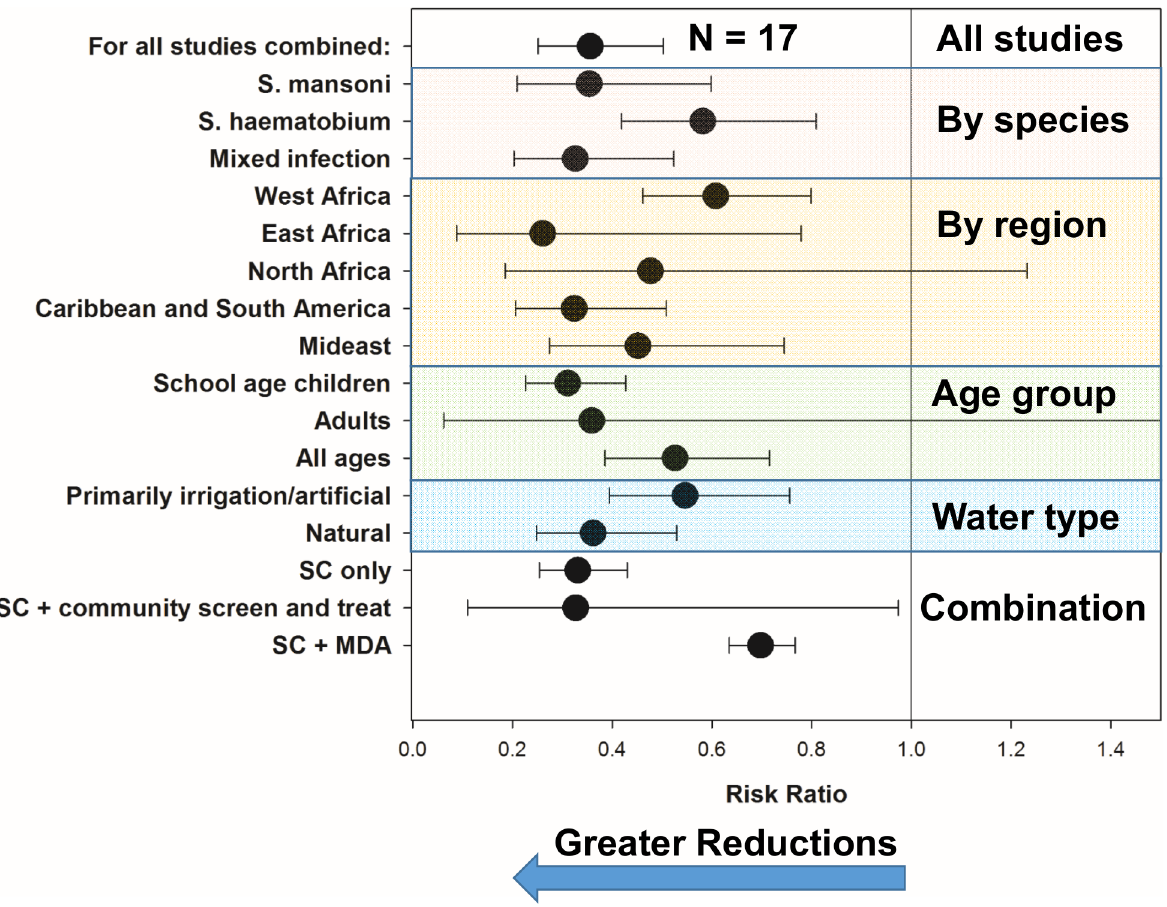
Fig 6. Risk ratios for interval Schistosoma infection incidence after implementation of mollusciciding programs. Black circles indicate risk ratios (RR) estimated by random effects meta-analysis for Schistosoma infection incidence after mollusciciding, as compared to pretreatment levels. Whisker bars indicate the 95% confidence interval for the RR estimates. Numeric details are provided in Supporting Information file S3 Table. Results are shown for all studies reporting human incidence data after implementation of control (top line, N = 17), and for study subgroup categories classified according to parasite species, geographic region, which age groups were included, the types of water bodies treated, and whether the program included snail control (SC) only, or mollusciciding combined with some form of drug treatment intervention, including targeted mass drug administration (MDA).